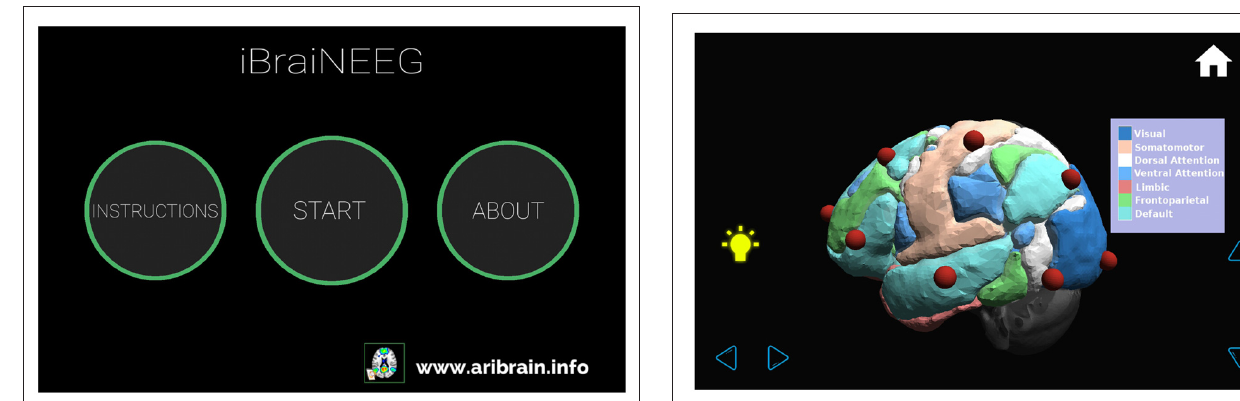
FIGURE 7 | iBraiNEEG2 main window. iBraiNEEG2 user instructions will be shown by touching the “Instructions” button; by pressing “About” the iBraiNEEG2 authoring information appears, and “Start” shows the transparent brain with the seven connectivity networks (Yeo et al., 2011) and red spheres for the 10–20 electroencephalography (EEG) electrodes ( Figure 8 ).